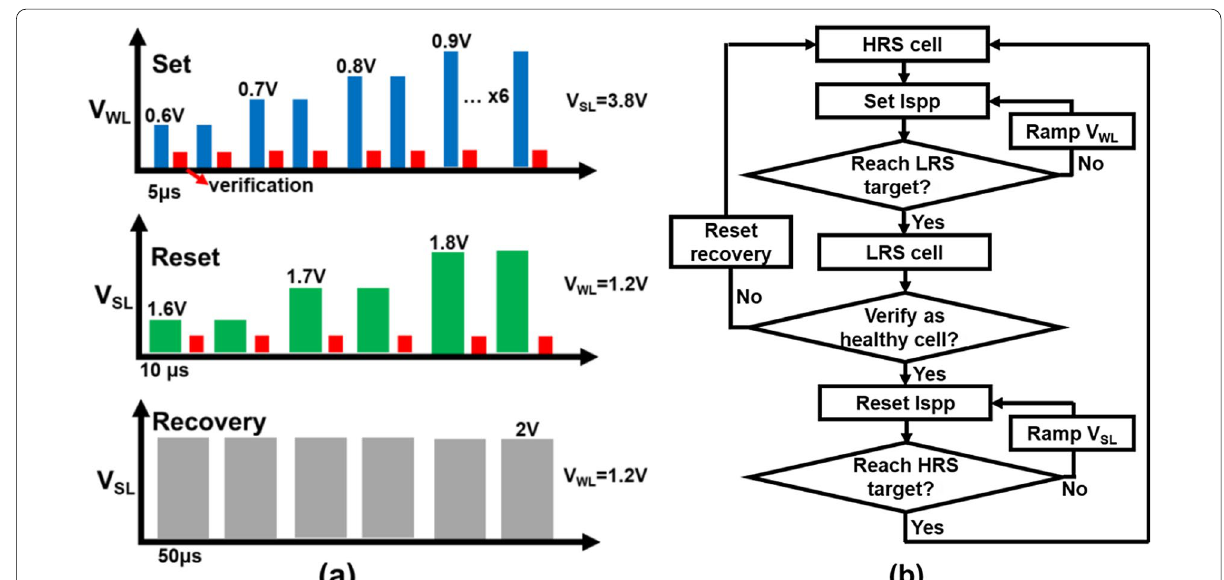
Fig. 5 a The set/reset ISPP algorithm and recovering reset conditions for cycling tests. The V WL and V SL are ramped, respectively, in set/reset operations. b The algorithm for early detecting the weak cells